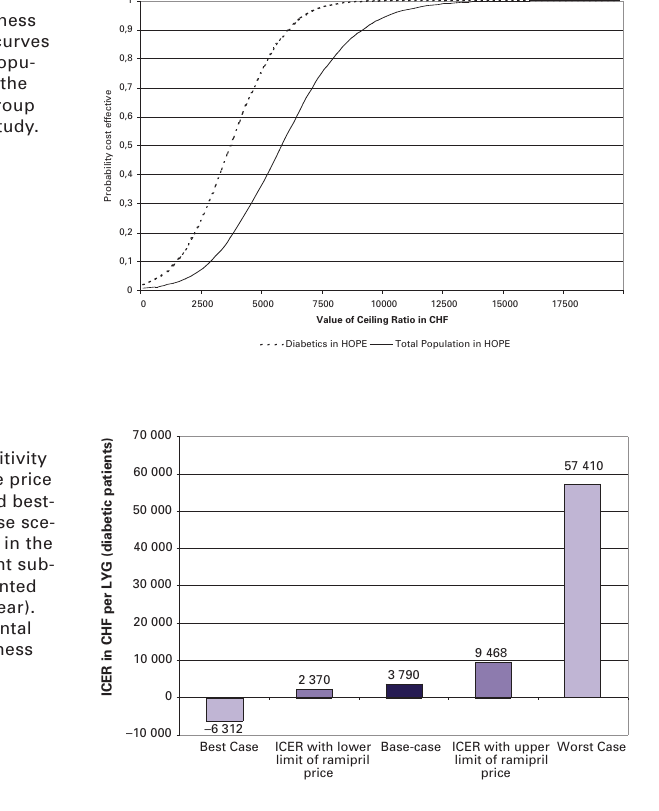
Figure 3 Cost-effectiveness acceptability curves for the total popu- lation and for the diabetic subgroup in the HOPE study.